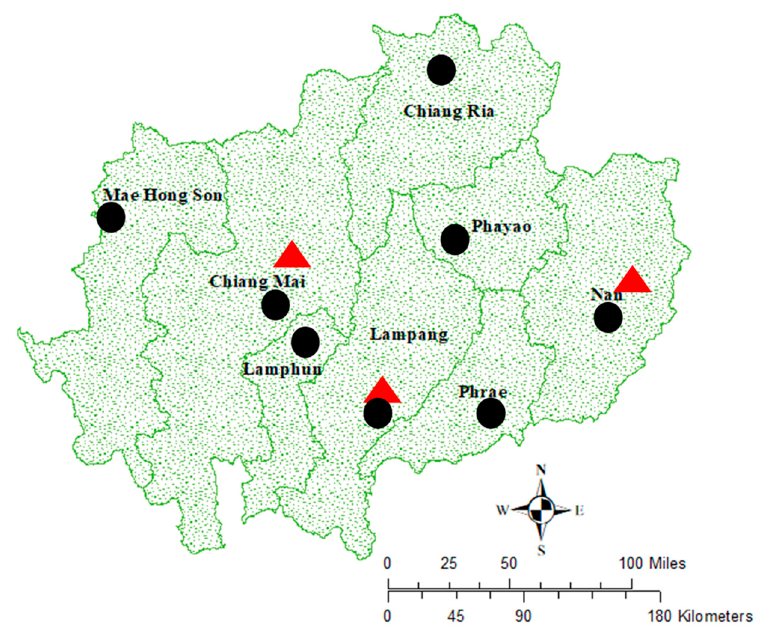
Figure 2. Location of meteorological station (black dot) from the Thai Meteorological Department and Pollution Control Department (red triangle) in Thailand.